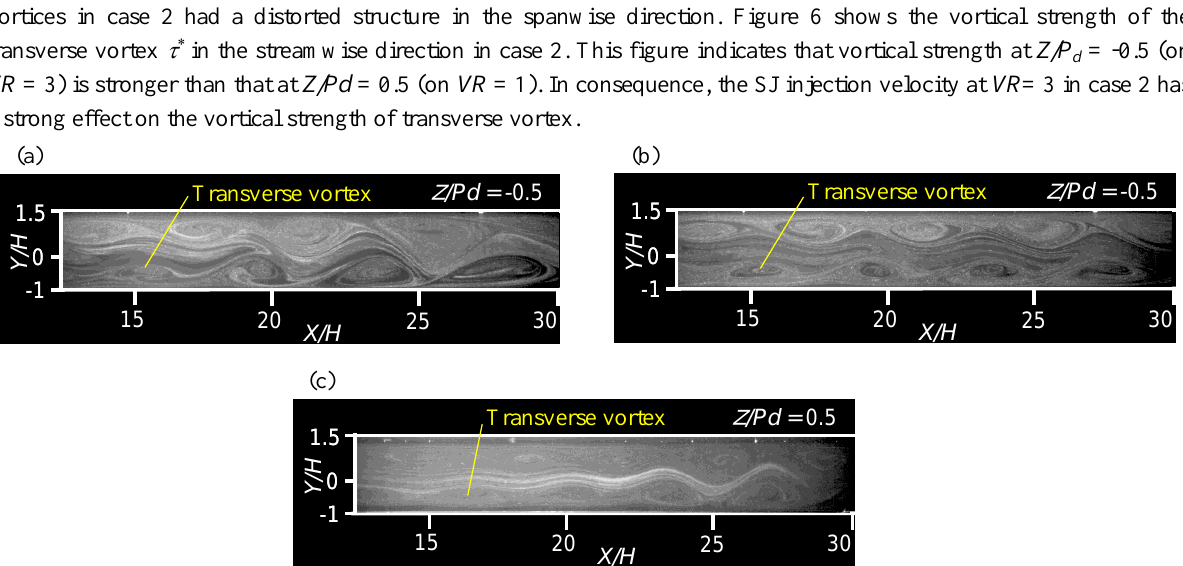
Fig. 5 Flow visualization in X-Y section at Re = 300 and F VR = 3 jet), (b) case 2 at Z/P